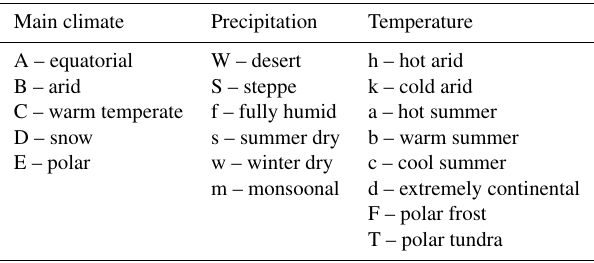
Table 2. Köppen–Geiger climate classification system (Kottek et al.,